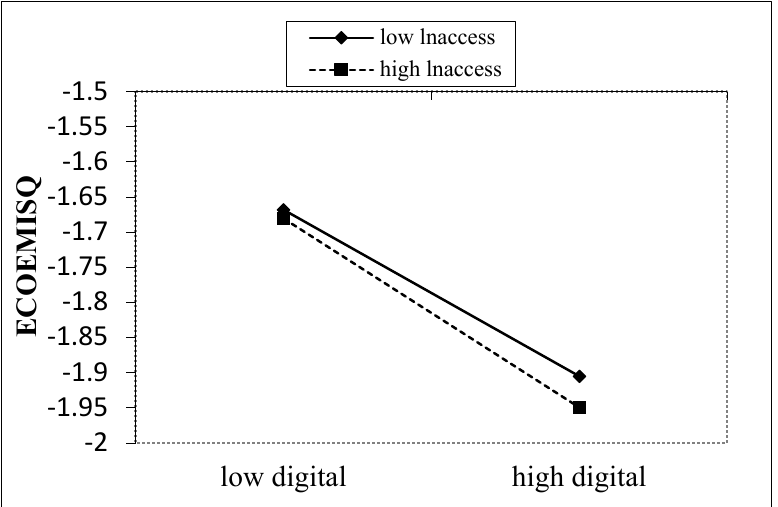
Figure 2. Reconciliation of digital information resources.